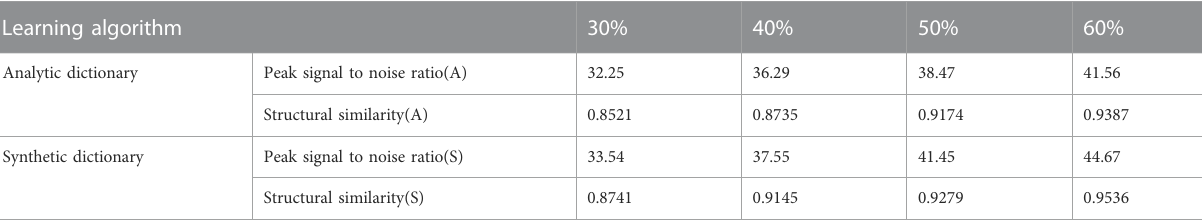
TABLE 6 Effect of optimization of MR technology using various deep learning algorithms. Learning algorithm